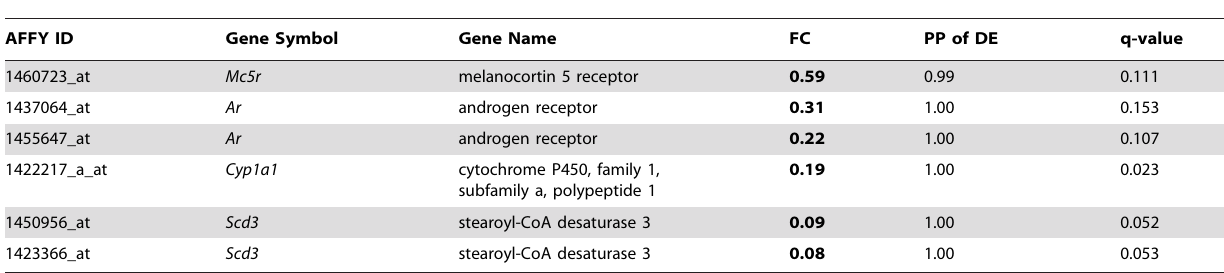
Table 3. Sebaceous gland or sebocyte markers.